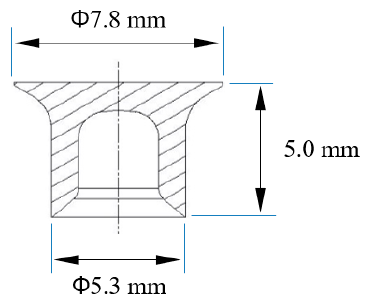
Figure 1. Vibration-damping aluminum (Al) panel cross-sectional view under an optical microscope. Table 1. The ultimate tensile strength and thickness of the materials tested here. The results for three different directions ( 0 ° , 45°, and 90°) are shown for carbon-reinforced plastic (CFRP).